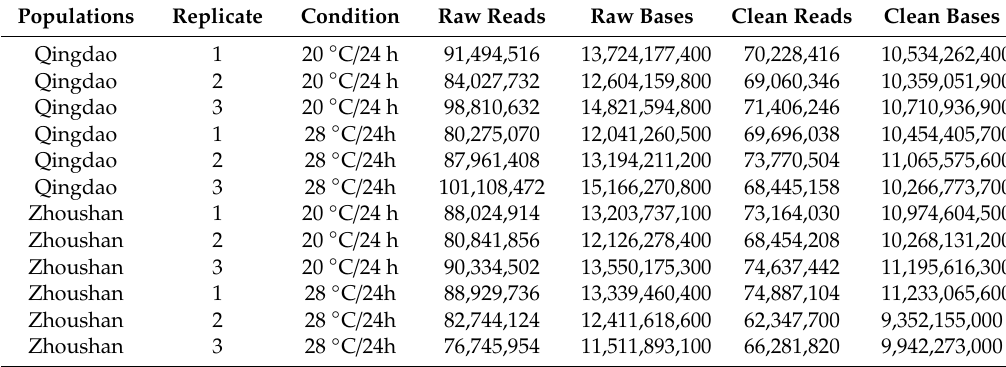
Table 2. The numbers of raw and clean RNA-seq reads from each sample.